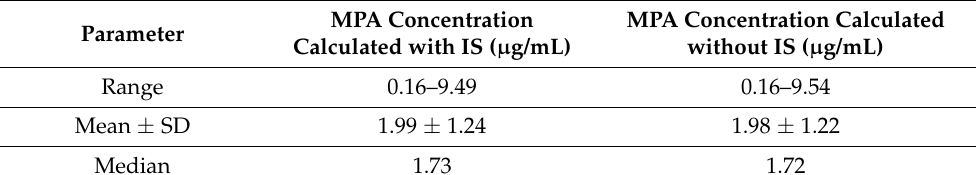
Table 5. MPA concentrations in heart transplant patients samples ( n = 1187).